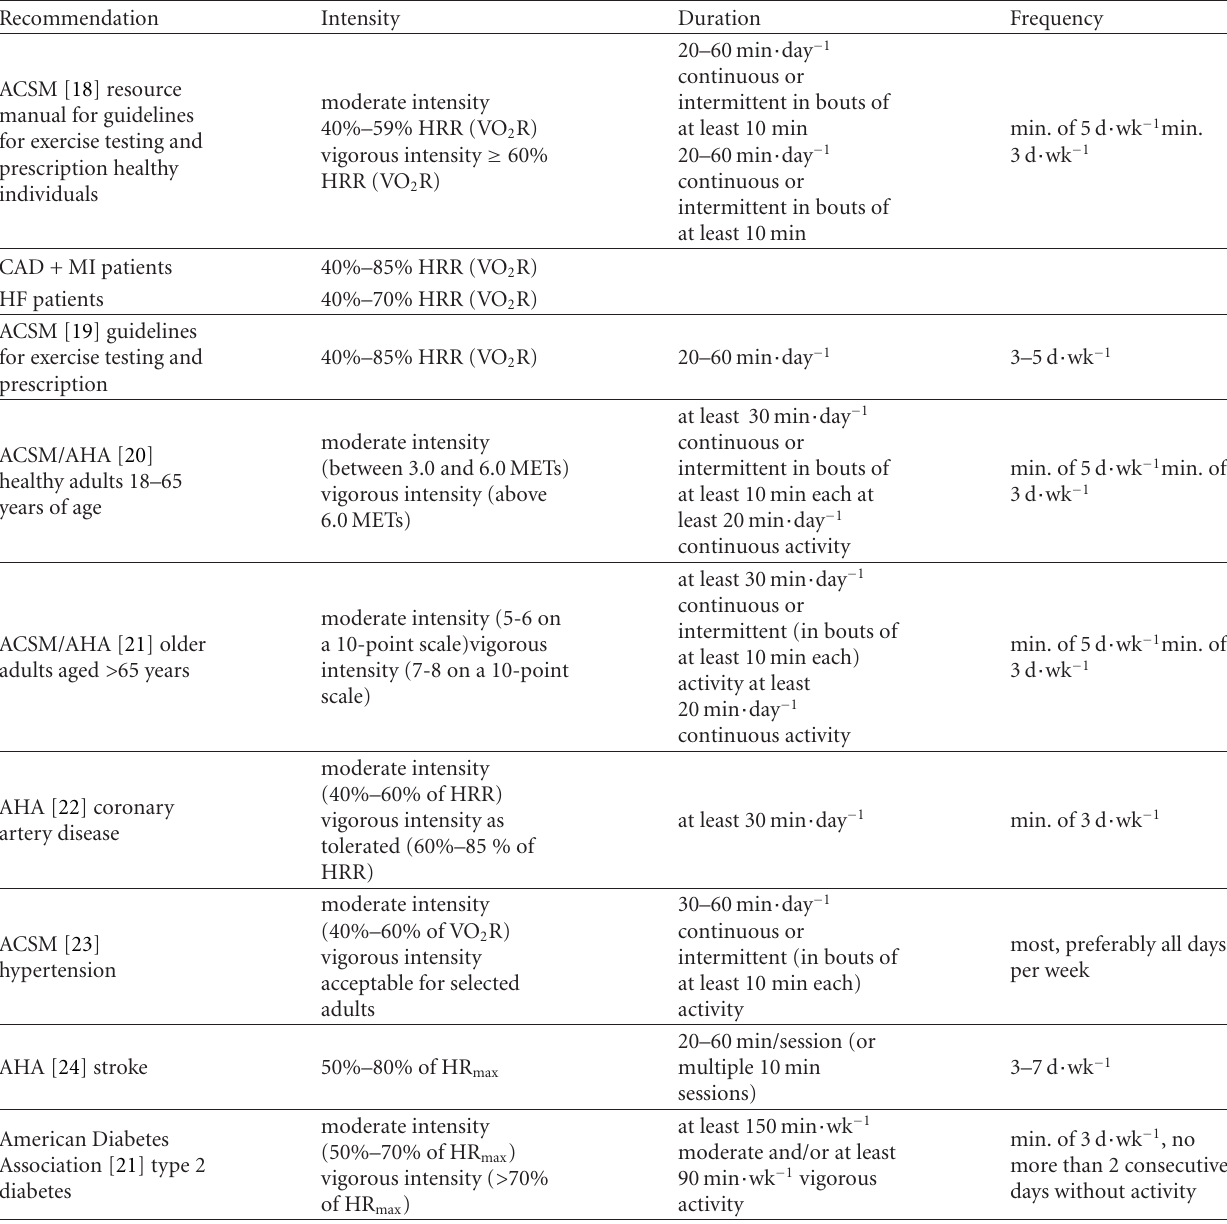
Table 1: Overview of recommendations for physical activity and public health in healthy adults and